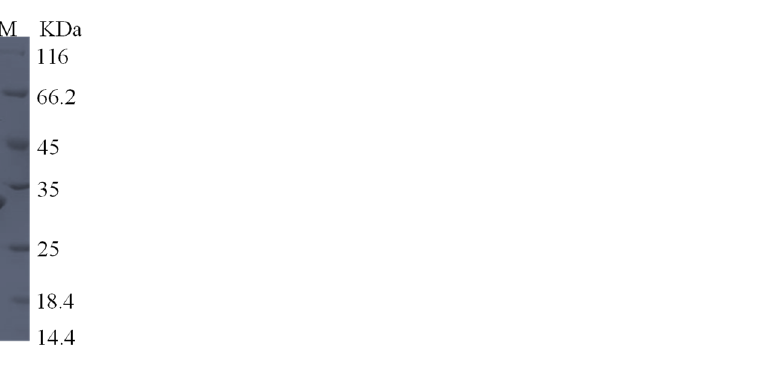
Figure 3. SDS-PAGE analysis of GmASNase; M, protein marker; lane 1, purified GmASNase. Table 1. Separation and purification of GmASNase.